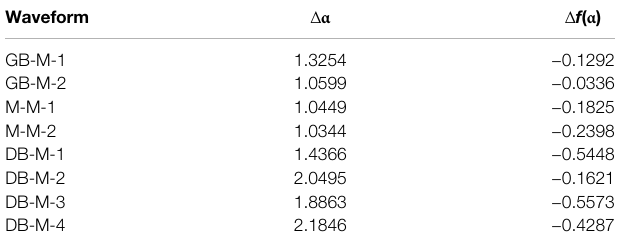
TABLE 2 | Multifractal parameters of Δ α and Δ f ( α ). Waveform